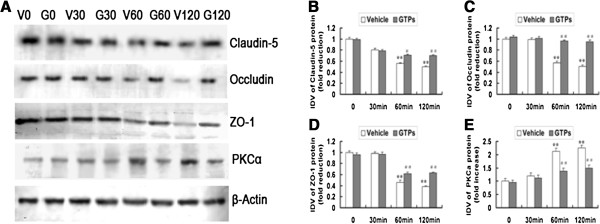
Effects of GTPs on the protein expression levels of claudin-5, occludin, ZO-1, and PKCα in ischemic cerebral microvessels after cerebral ischemia were determined by western blot. (A) The lanes are the following groups: V0–V120, 0, 30, 60, and 120 min after ischemia in the vehicle group; G0–G120, 0, 30, 60, and 120 min after ischemia in the GTPs-treated group. β-Actin served as a internal control. IDVs of claudin-5 (B), occludin (C), ZO-1 (D) and PKCα (E) are expressed as a fold reduction or a fold increase relative to the vehicle group of ischemia at 0 min. Data represent the means ± SD (n = 6, each). ** P < 0.01 vs. vehicle group of ischemia 0 min. #P < 0.05, ##P < 0.01 vs. vehicle group at the same time points.